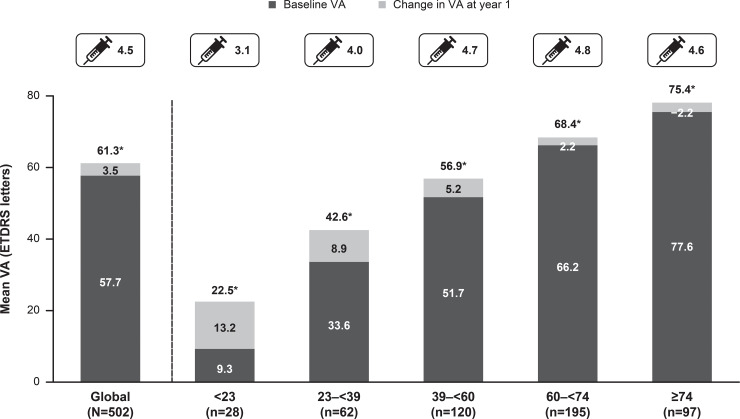
Mean change in visual acuity by baseline visual acuity stratification (primary treated eye set).Observed data set for VA change. The primary treated eye set included all primary treated eyes in patients included in the safety set. The safety set consisted of patients in the enrolled set who were treated with at least one dose of ranibizumab during this study or prior to the start of the study and had at least one safety assessment after the first treatment. *The values represent the final VA at year 1. For treatment-naïve eyes, the date of first on-study injection with ranibizumab was considered the baseline date. For the 1-year time period, all patients with non-missing baseline VA and year 1 VA performed anywhere between Day 319 and Day 409 but who had been in the study for at least 365 days from baseline to last follow-up date were included in the analysis. ETDRS, Early Treatment Diabetic Retinopathy Study; VA, visual acuity.